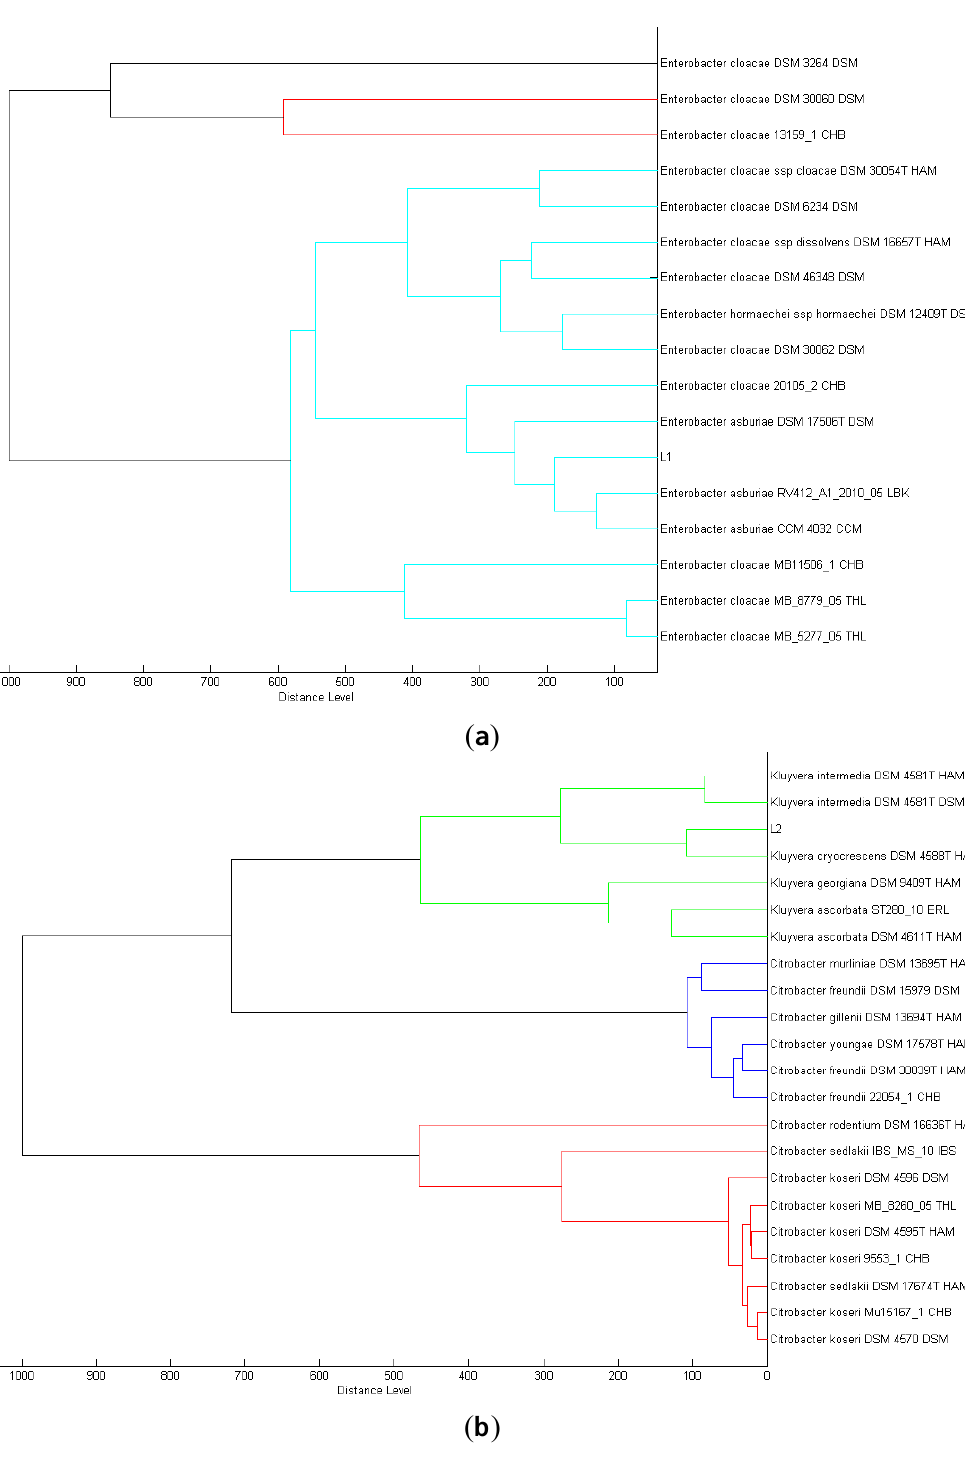
Figure 1. Phylogenetic positions of ( a ) L1, ( b ) L2, ( c ) L3 and ( d ) L4 isolates, visualized using the standard MALDI Biotyper MSP. The different colors of the branches represent distinct clusters among the organisms in the